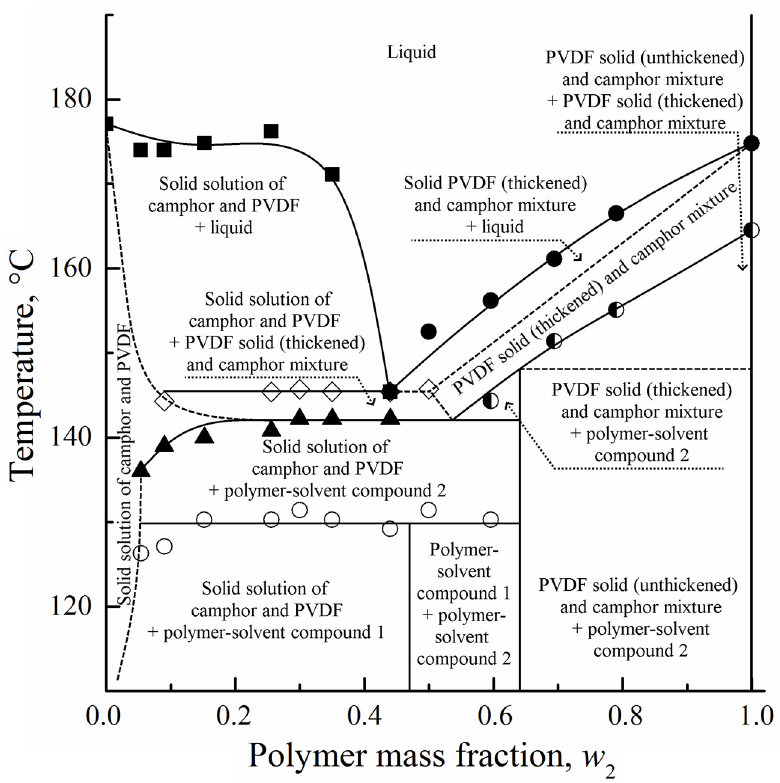
Figure 1. Phase diagram of PVDF–camphor, adapted from [34].